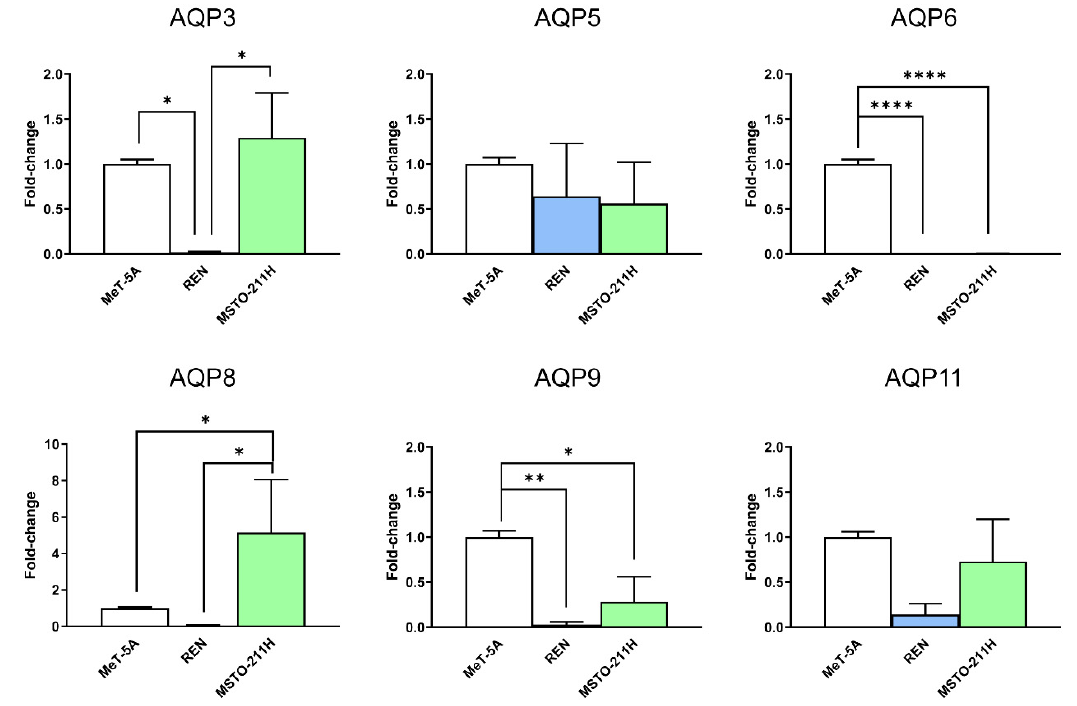
Figure 1. qRT-PCR reaction analysis of AQP3, AQP5, AQP6, AQP8, AQP9, and AQP11 expression in mesothelial (MeT-5A , in white), epithelioid, and biphasic MPM cell lines (REN and MSTO-211H, in blue and green, respectively). Bars represent the mean ± SEM of fold change values (n = 4). *, p < 0.05; **, p < 0.01; ****, p < 0.0001 (ANOVA followed by Newman–Keuls’s Q test).